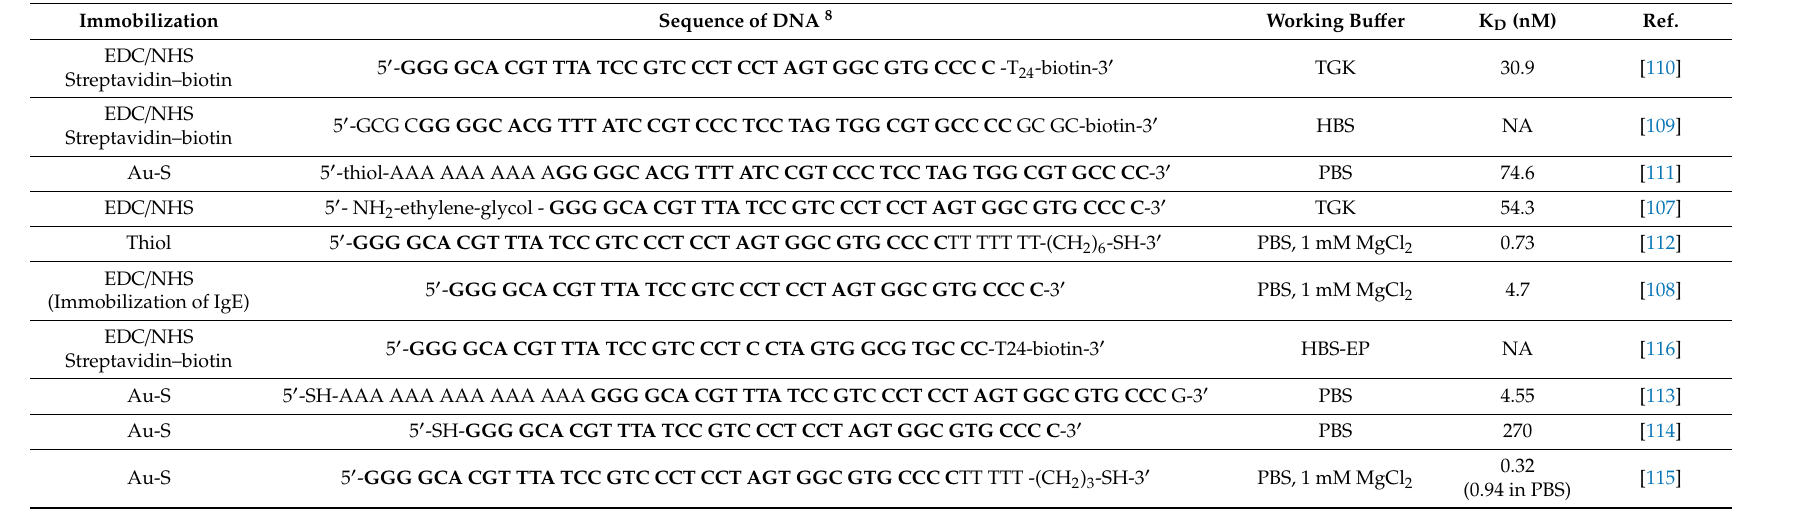
Table 9. Parameters of SPR measurements of D17.4 aptamer–IgE